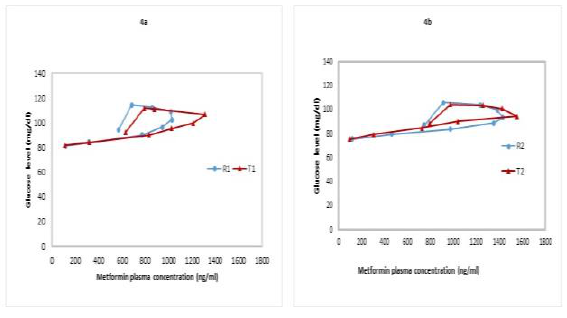
Fig. 3. Mean Percent change from baseline glucose level versus time curves after performing the oral glucose tolerance test (OGTT) for metformin 500 mg (3a) or 1000 mg (3b) alone (R1 &R2) and with daclatasvir (T1&T2)